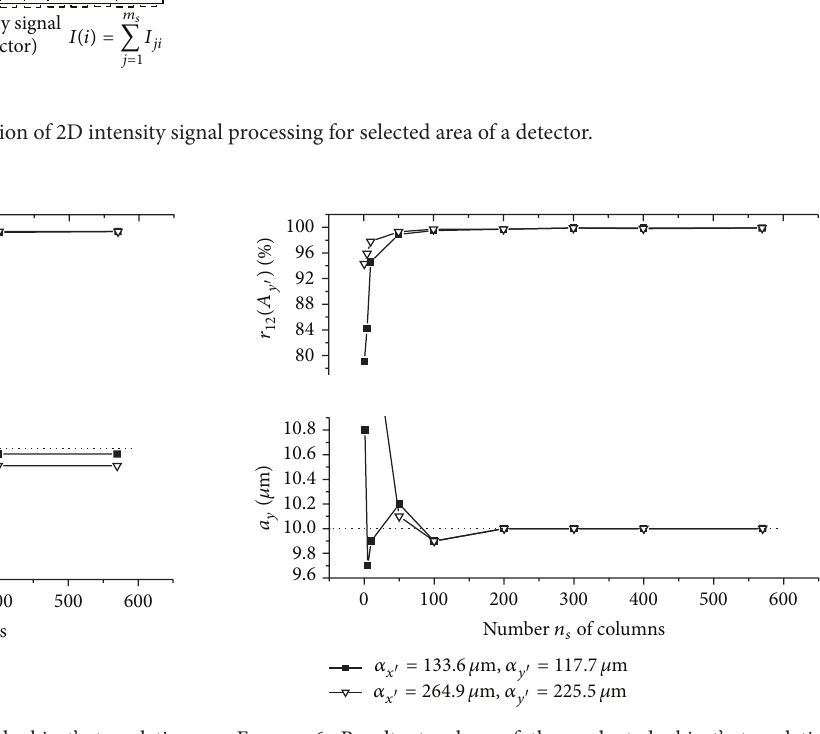
Figure 6: Resultant values of the evaluated object’s translation component 𝑎 𝑦 aswellasthemaximum 𝑟 12 (𝐴 𝑦 󸀠 ) ofthe1Dnormalized cross-correlation function 𝑟 12 of the intensity signals 𝐼 1 and 𝐼 2 as a function of number 𝑛 𝑠 of rows of the area used for the 2D intensity signal processing. The object is translated by 𝑎 𝑥 = 𝑎 𝑦 = 10 𝜇